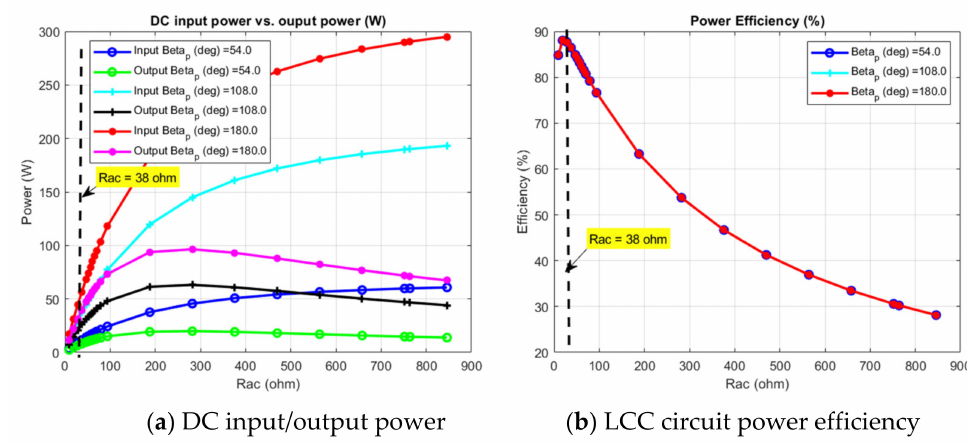
Figure 9. DC input/output power and efficiency vs. AC load resistance